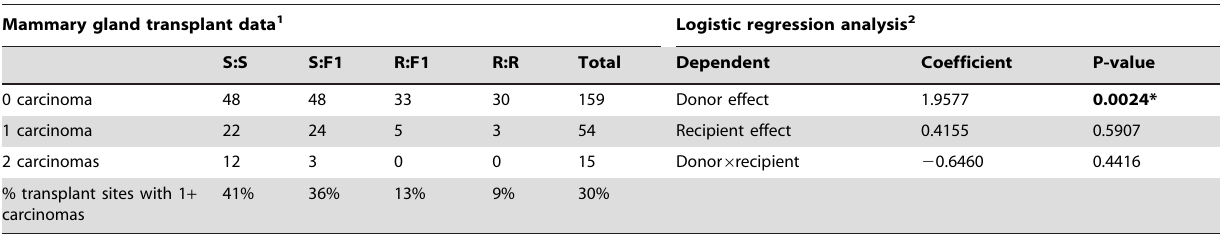
Table 1. Mammary gland transplantation data and logistic regression